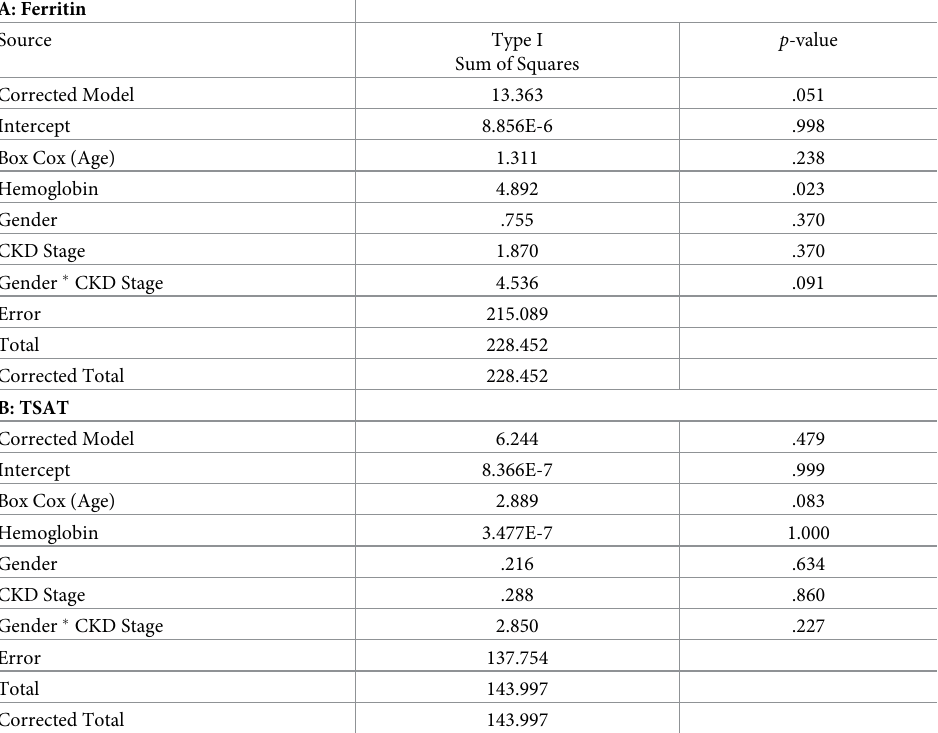
Table 4. Analysis of covariance of inverse normal transform (INT) of ferritin rank (A) and TSAT rank (B). A: